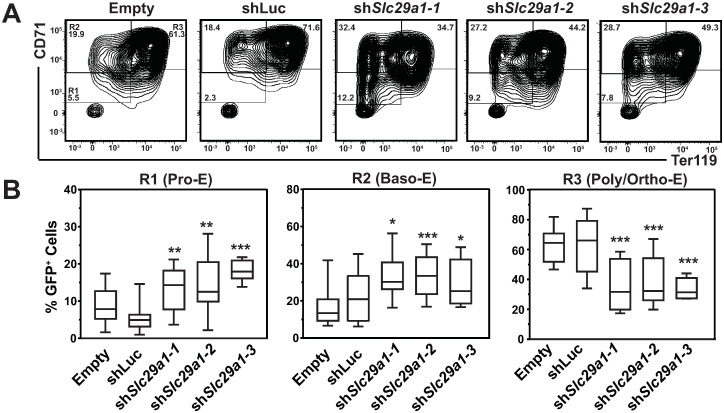
Slc29a1 promotes erythroid differentiation.(A) Flow cytometric analysis of erythroid markers CD71 and Ter119 in live GFP+-gated control and Slc29a1-shRNA infected erythroid precursor cells expanded for two days followed by three days of erythroid differentiation. (B) Quantification of the percentage of live GFP+-gated control and Slc29a1-shRNA infected conditions from R1-R3 gates (R1; proerythroblasts, R2; basophilic erythroblasts, R3; poly/orthochromatic erythroblasts). n = 12 per condition. Data are from 4 independent experiments. For the box-and-whisker plots, the box depicts the 25th to 75th percentiles of data, the median line, and whiskers ranging from minimum to maximum values. Statistical analysis was carried out using an unpaired 2-tailed Student’s t test to compare Slc29a1 shRNA- and luciferase shRNA-infected cells. * p < 0.05, ** p < 0.01, *** p < 0.001, **** p < 0.0001.